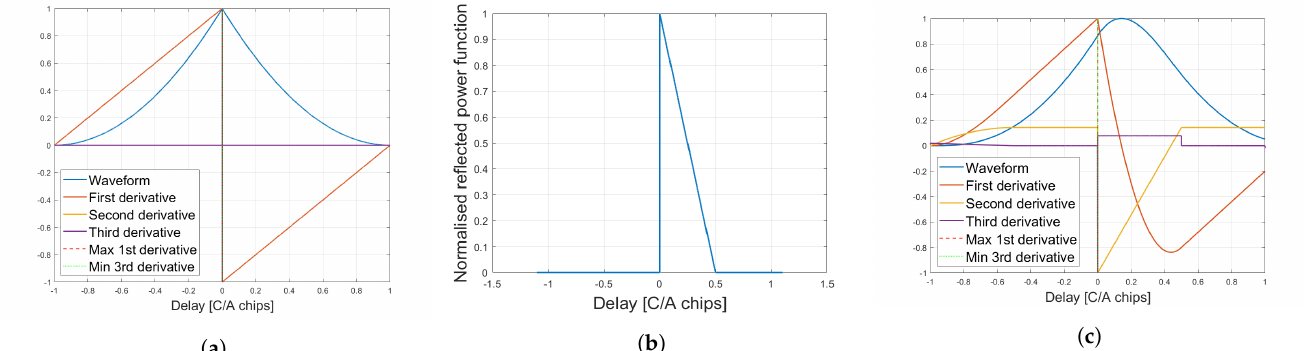
Figure 6. ( a ) Simulated ideal L1 C/A waveform, with infinite bandwidth, and its first, second, and third derivatives. ( b ) Simulated reflected power function as a function of the delay. ( c ) Simulated L1 C/A reflected waveform (convolution of a and b ). The maximum of the first derivative, and minimum of the third derivative correctly track the delay 0.